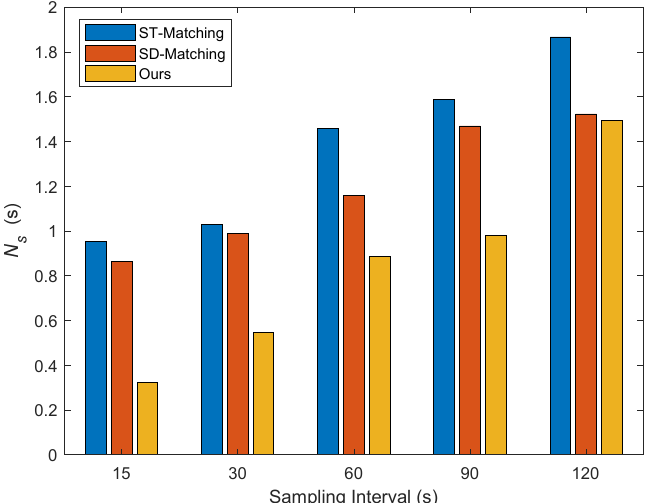
Figure 13. Comparison of the running times of the algorithms at different sampling frequencies.